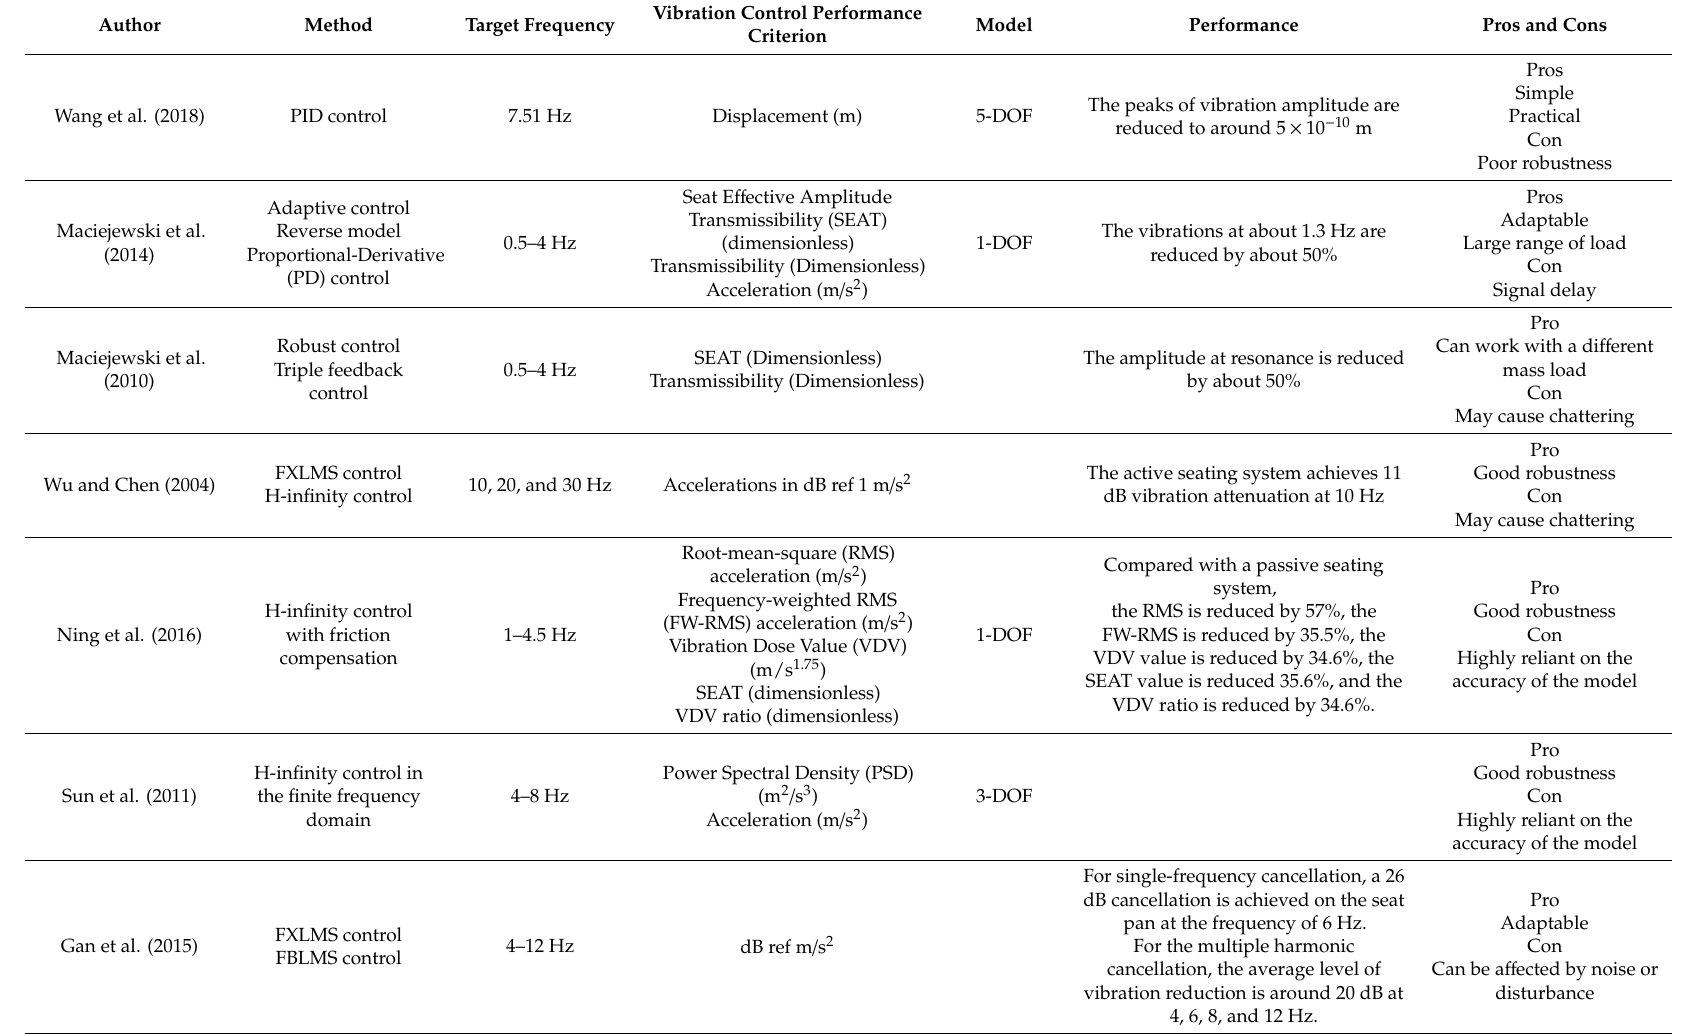
Table 2. Summary of the control system